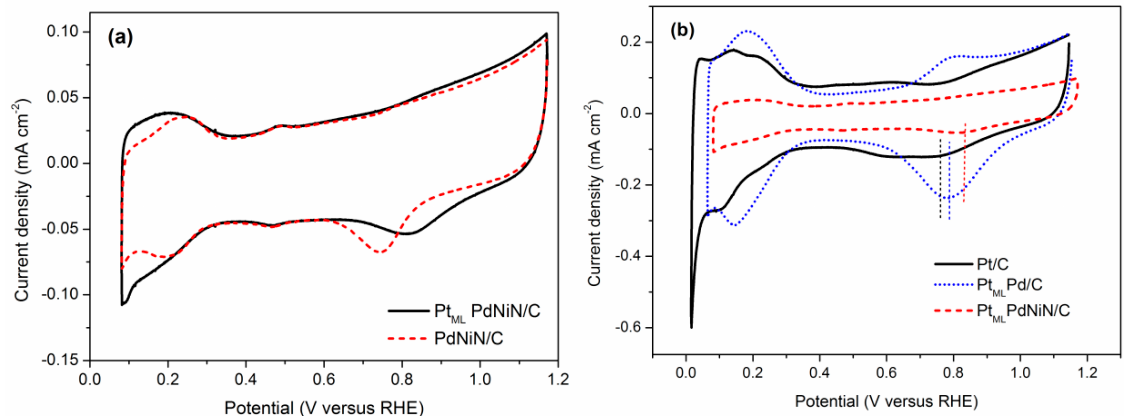
Figure 3. Cyclic voltammograms for ( a ) obtained PdNiN/C and Pt ML PdNiN/C; and ( b ) commercial Pt/C, Pt ML Pd/C and Pt ML PdNiN/C nanoparticles in 0.1 M HClO 4 solution